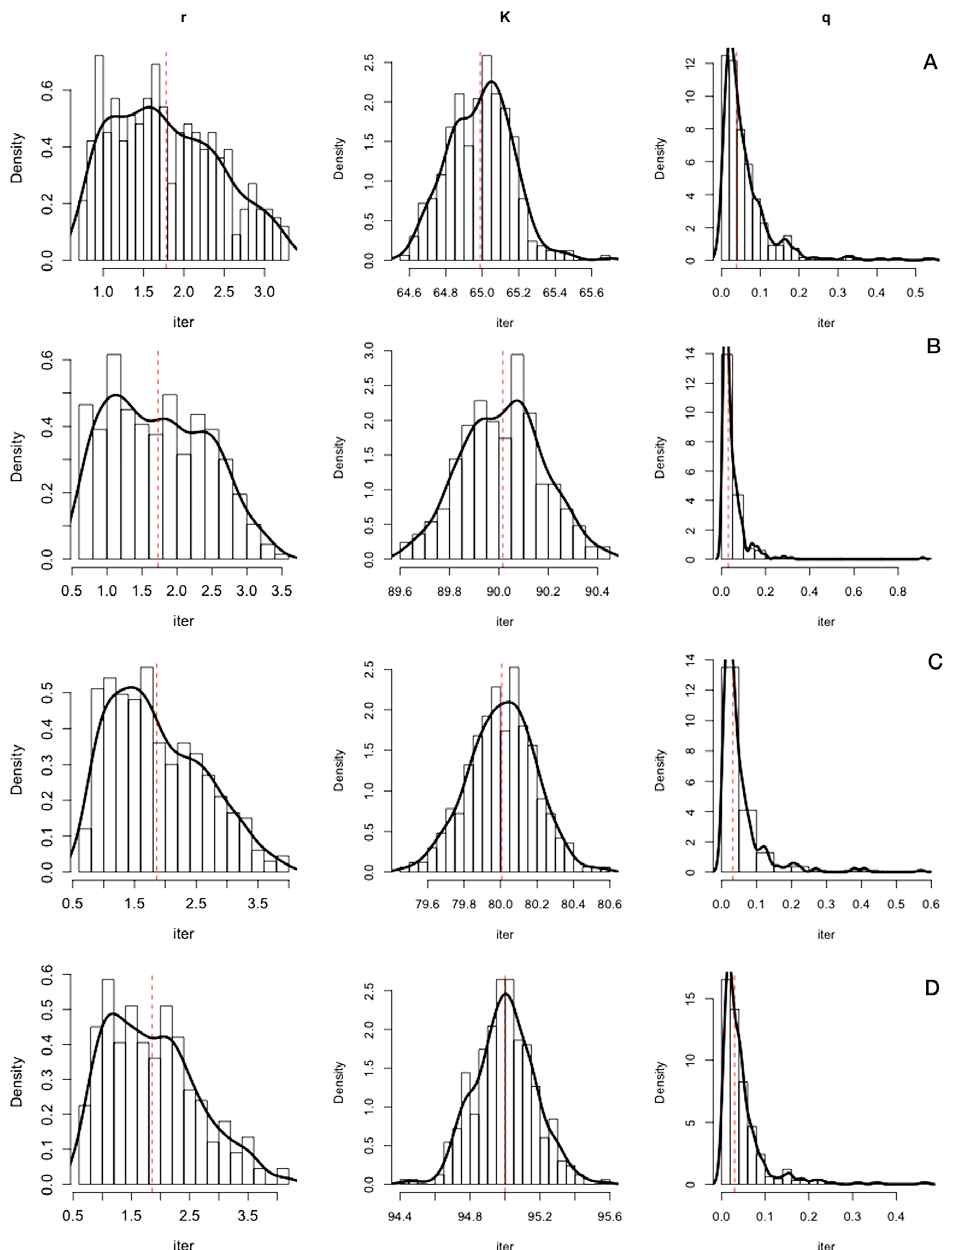
Fig. 3. – Density for r, K, q in (A) the SP model; B, the P